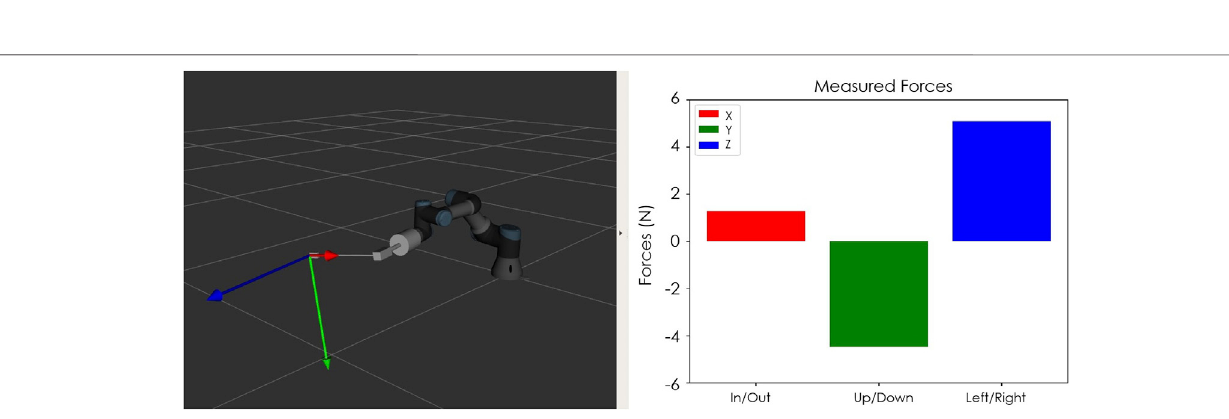
Frontiers in Robotics and AI |